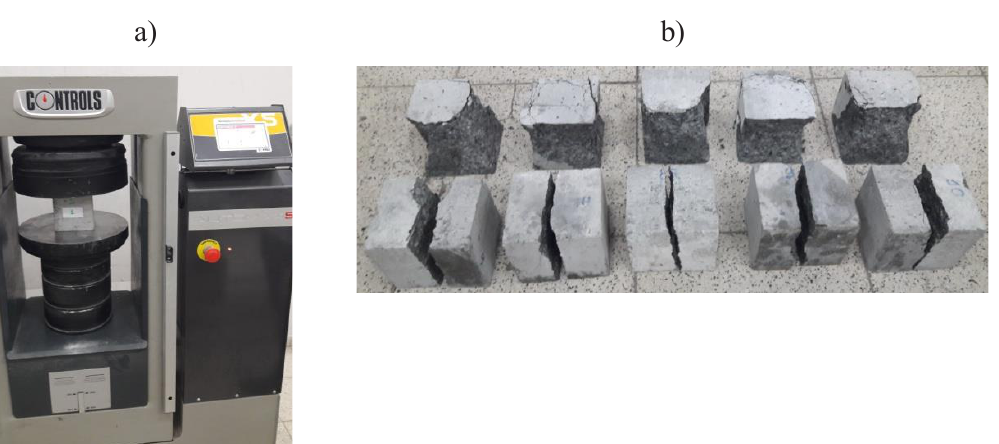
Fig. 4. Strength tests of concrete cube specimens; a) the Controls Automax5 strength testing machine; b)